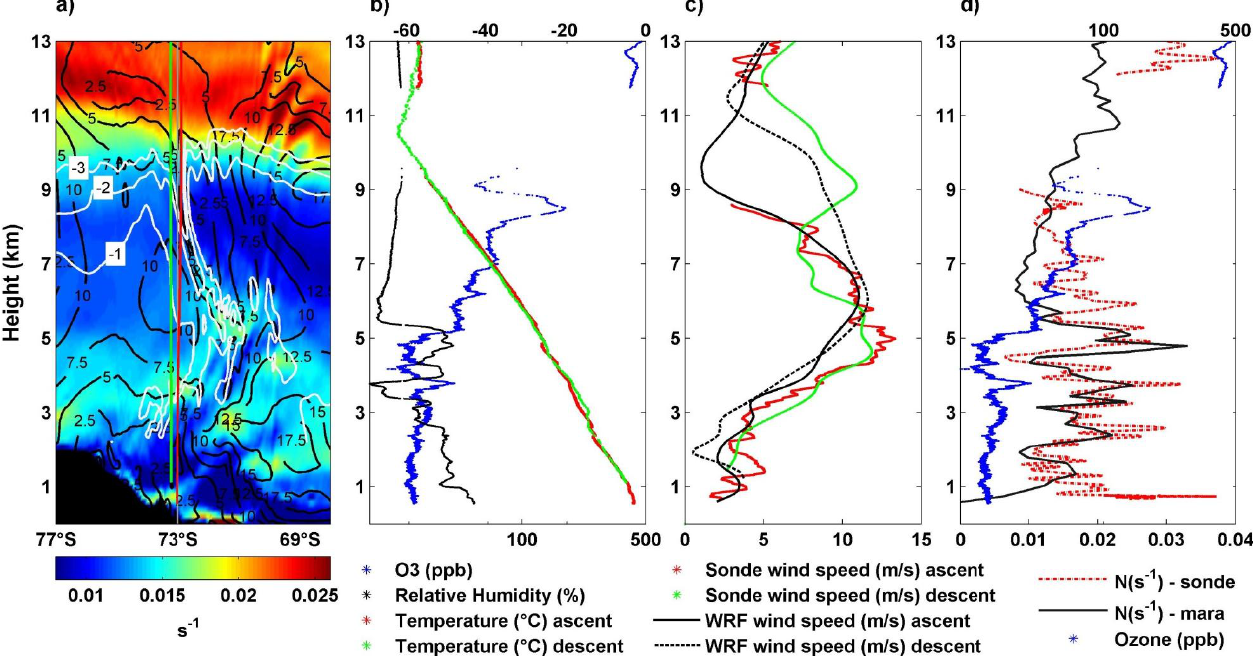
Fig. 7. Comparison of WRF cross-section with ozonesonde observations. (a) WRF cross-section of buoyancy frequency (s − 1 ) and wind speeds (ms − 1 ) along 13.5 ◦ W. − 1pvu, − 2pvu and − 3pvu isolines are shown in white, vertical grey line represents MARA position, red line sonde ascent and green line sonde descent positions at 12:00UTC on 29 December 2011. (b) Sonde measurements of relative humidity (%, black), O 3 mixing ratio (ppb, blue) and temperature ( ◦ C, red – ascent, green – descent). (c) Sonde measurements of wind speed (ms − 1 , red – ascent, green – descent) and WRF model wind speed (ms − 1 , full line – ascent, dashed line – descent). (d) Comparison of O 3 mixing ratio (ppb, blue) and buoyancy frequency (s − 1 ) from sonde ascent (red dashed line) and MARA (full line) data. Due to loss of contact with the sonde between 9.5km and 12km height, the ascent data exhibits a gap in measurements. Temperature and wind measurements covering this gap are available from the descent, but not ozone or relative